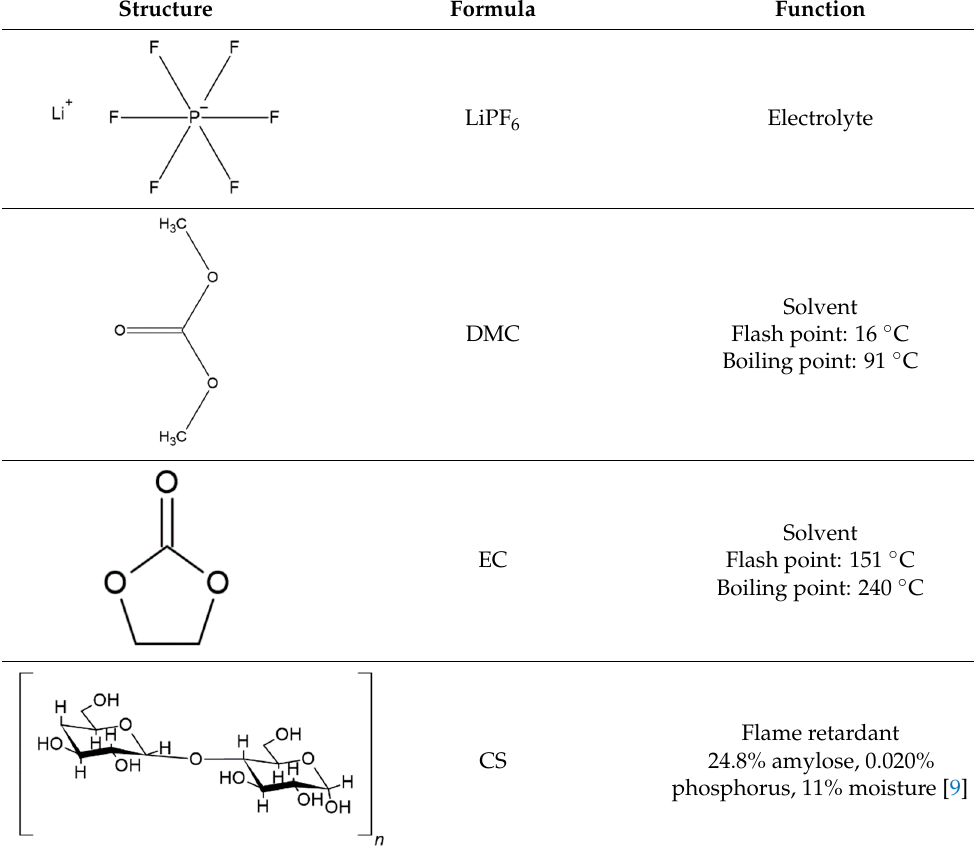
Table 1. Chemical reagents used in the experimental section.